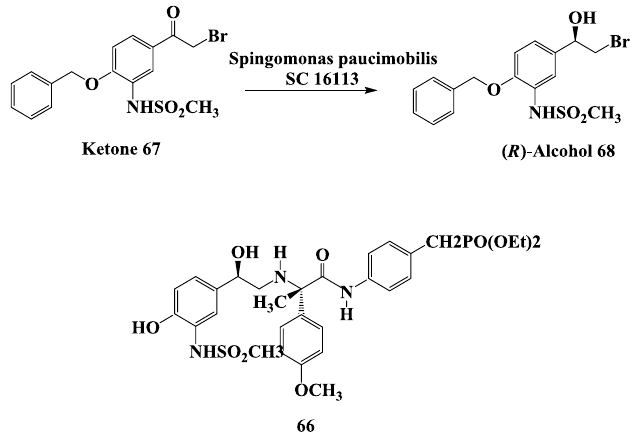
Figure 17.  3-Receptor agonist: Reduction of 4-benzyloxy-3-methanesulfonylamino-2-